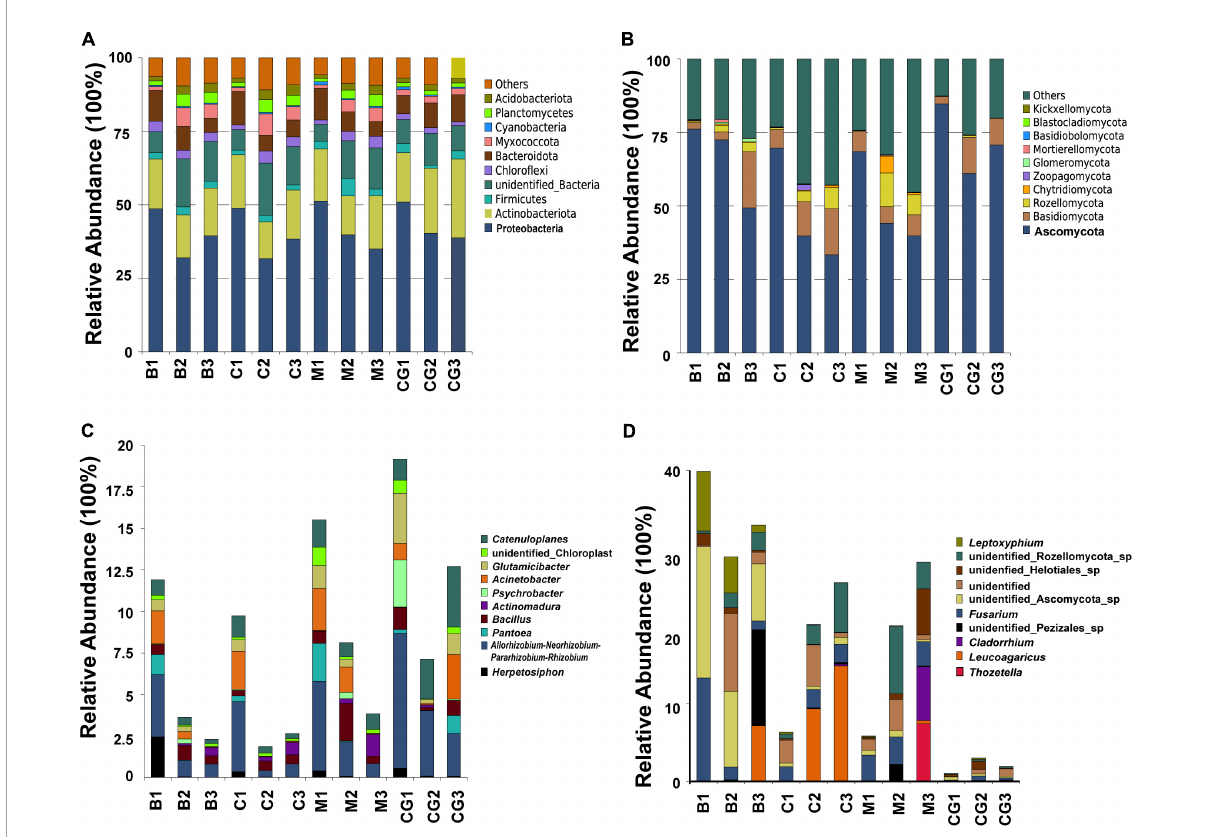
FIGURE2 Relative abundance of microbes at the phyla and genus levels according to nest material composition and incubation period. (A) The dominant bacteria phyla, (B) dominant fungi phyla, (C) dominant bacterial genera, and (D) dominant fungi genera. The letters in group ID represents nest material composition (B, bamboo leaf; C, couch grass; M, mixed litter; CG, control group); Arabic numerals represent different incubation periods (1, pre-incubation period; 2, mid-incubation period; 3, post-incubation